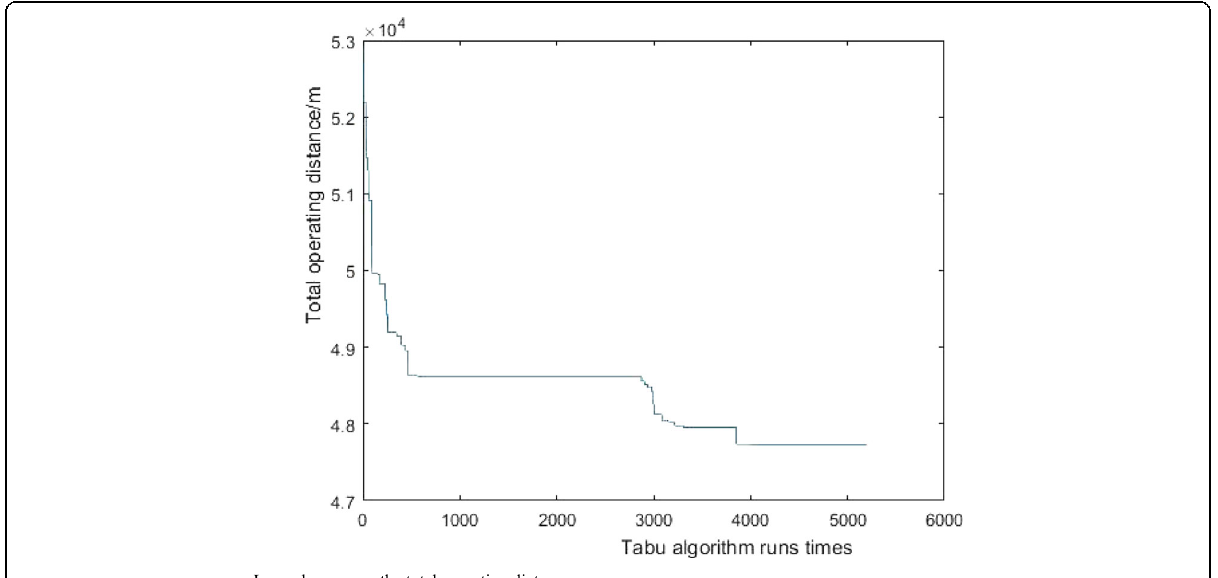
Fig. 4 When the tabu search algorithm was firstly used. The sequence total operation distance variation diagram. The blue line represents the